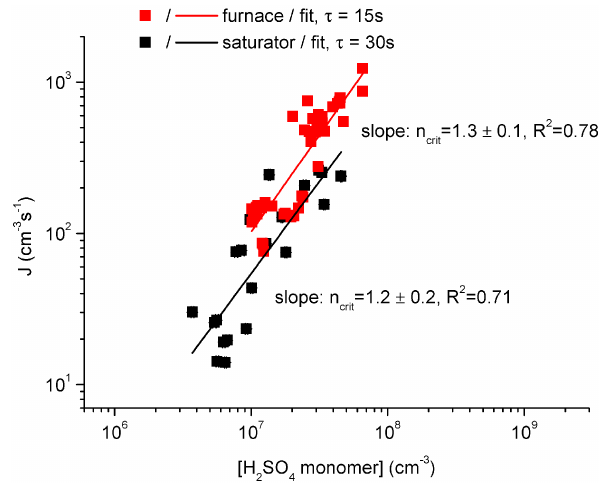
Figure 8. Formation rates J as a function of residual sulfuric-acid- monomer concentration [H 2 SO 4 monomer] at T = 298K and RH ∼ 30% measured using CIMS. In the first data set (red squares) sulfuric-acid vapor was produced with the furnace method, and the residence time was defined to be 15s (Brus et al.,